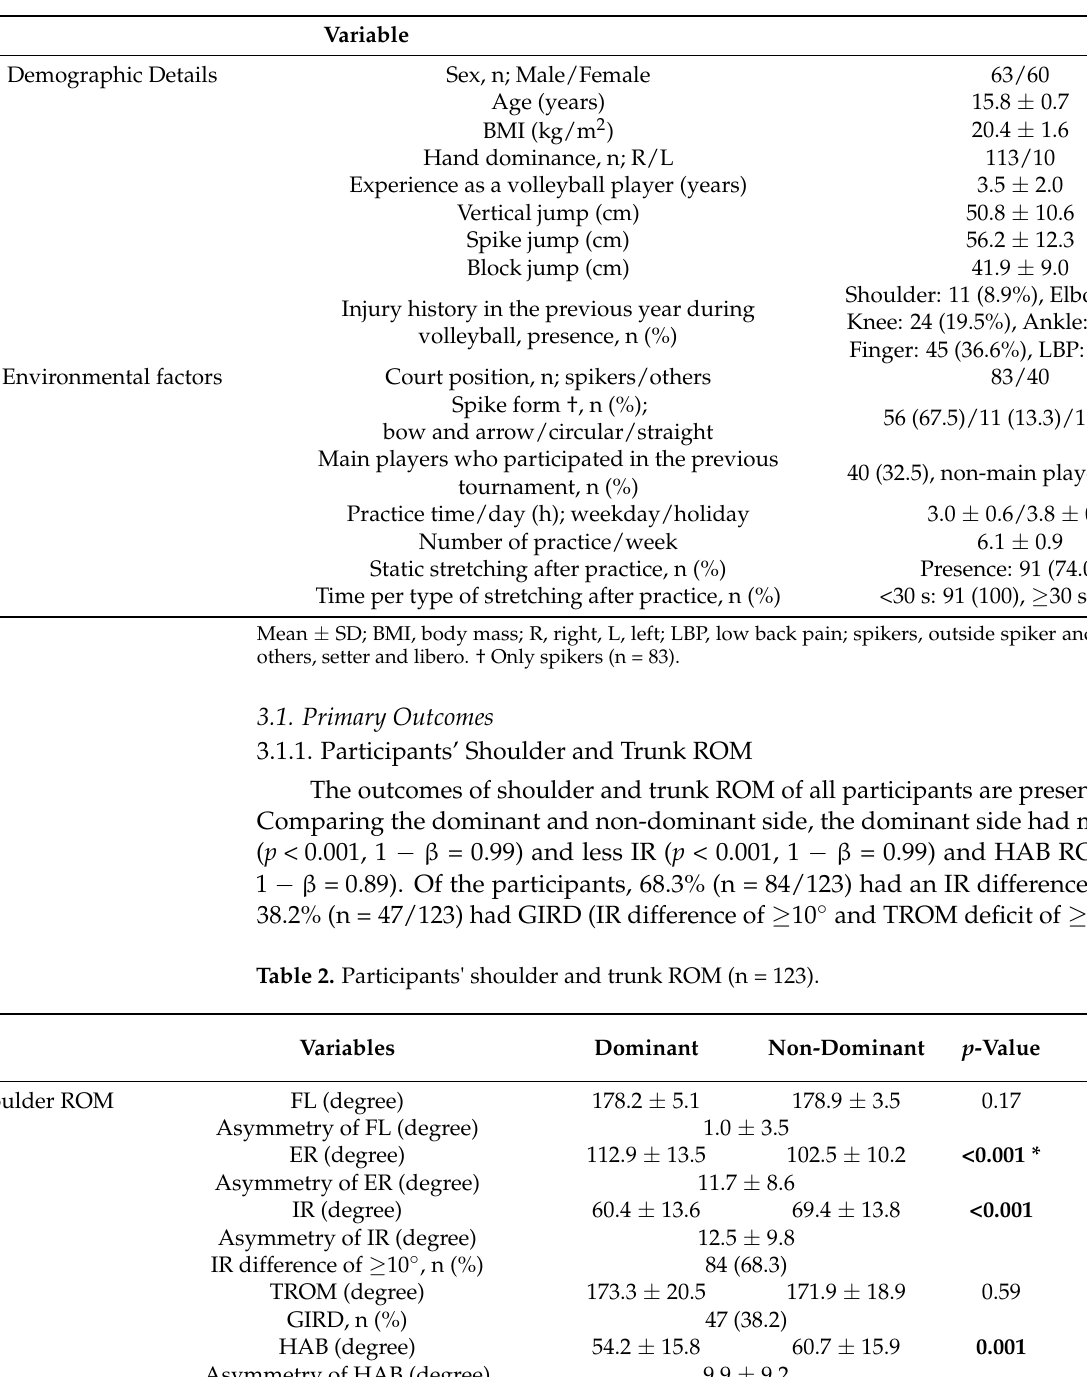
Table 1. Basic attributes and environmental factors of the participants (n = 123).